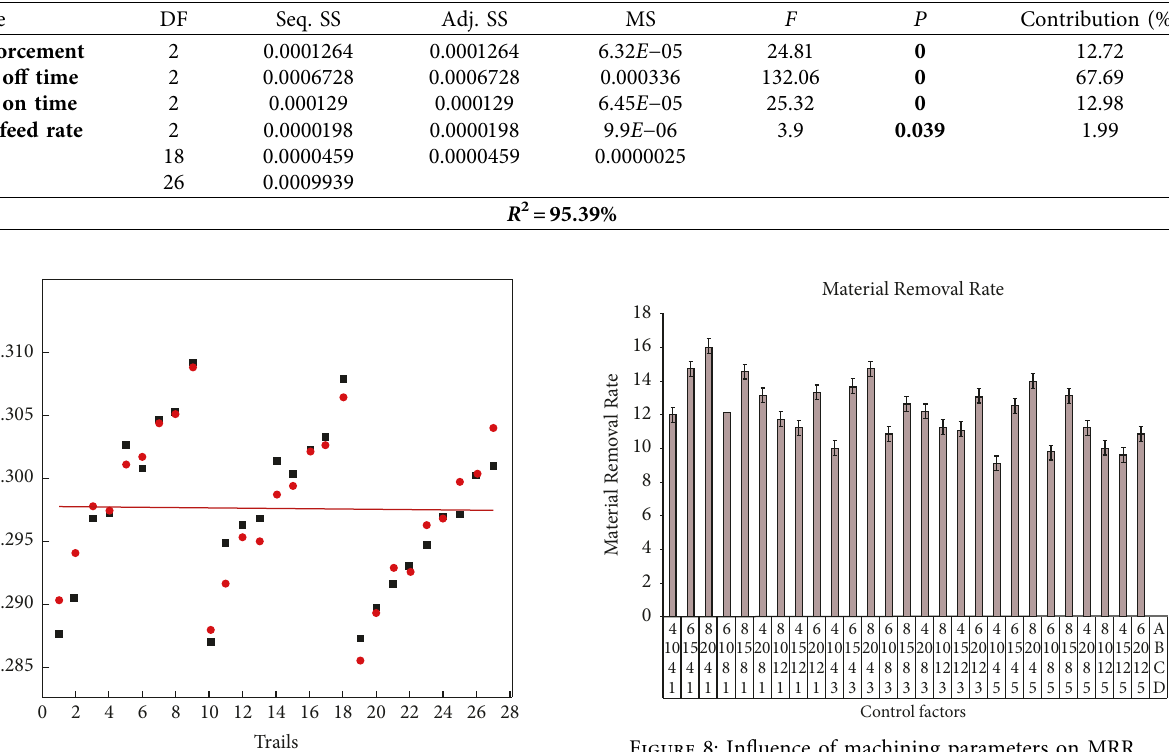
Table 6: ANOVA table for kerf width.